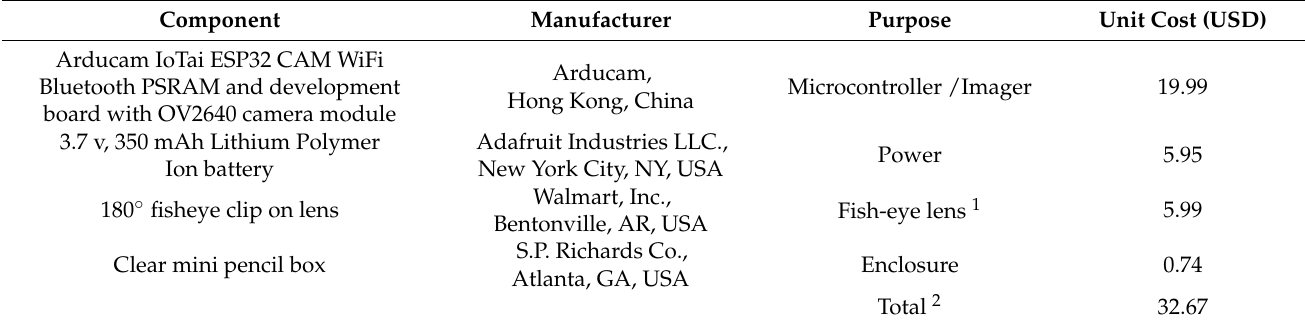
Table 1. Imaging system plug-in parts breakdown and associated